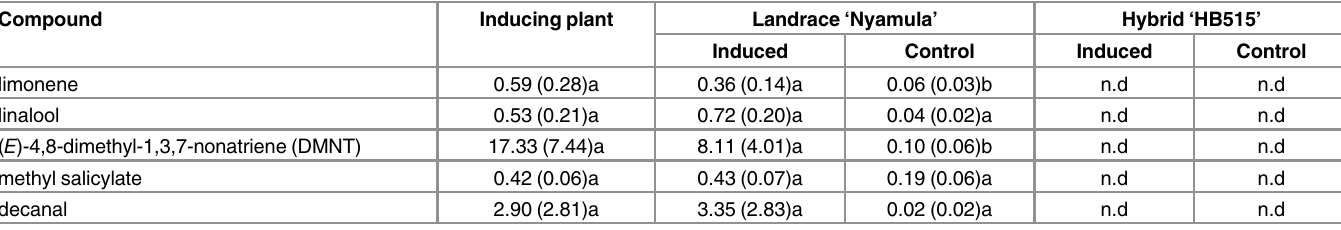
Table 1. Volatile emission (ng/plant/hr) (mean ± s.e) from egg exposed (inducing), neighbouring (induced) and control maize plants (N = 5).